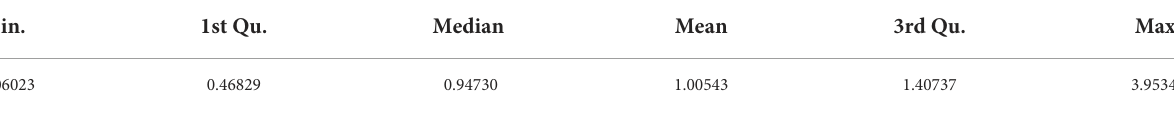
TABLE 3 Summary of vehicles age as of 31 December 2011 for the 2011 cohort.